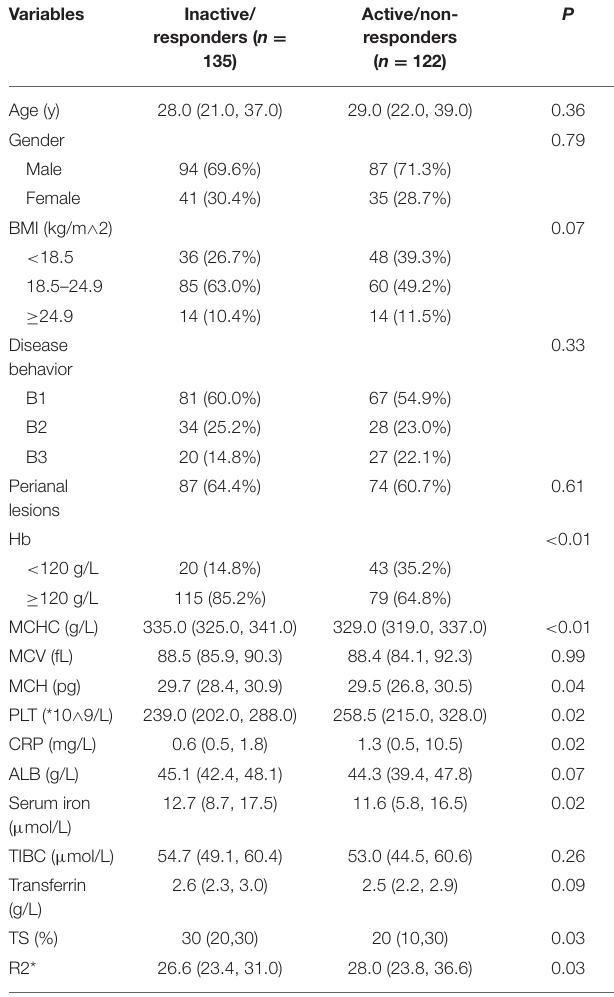
TABLE 3 | Results of univariate analysis of candidate variables for the training TABLE 2 | Correlations of secondary loss of response with R2 * and several iron status indices. r p p Hb − 0.242 < 0.001 serum iron − 0.142 0.023 TS − 0.139 0.026 R2* 0.242 < 0.001 r p , correlation coefficient for Point-biserial analysis; Hb, hemoglobin; TS, transferrin saturation.